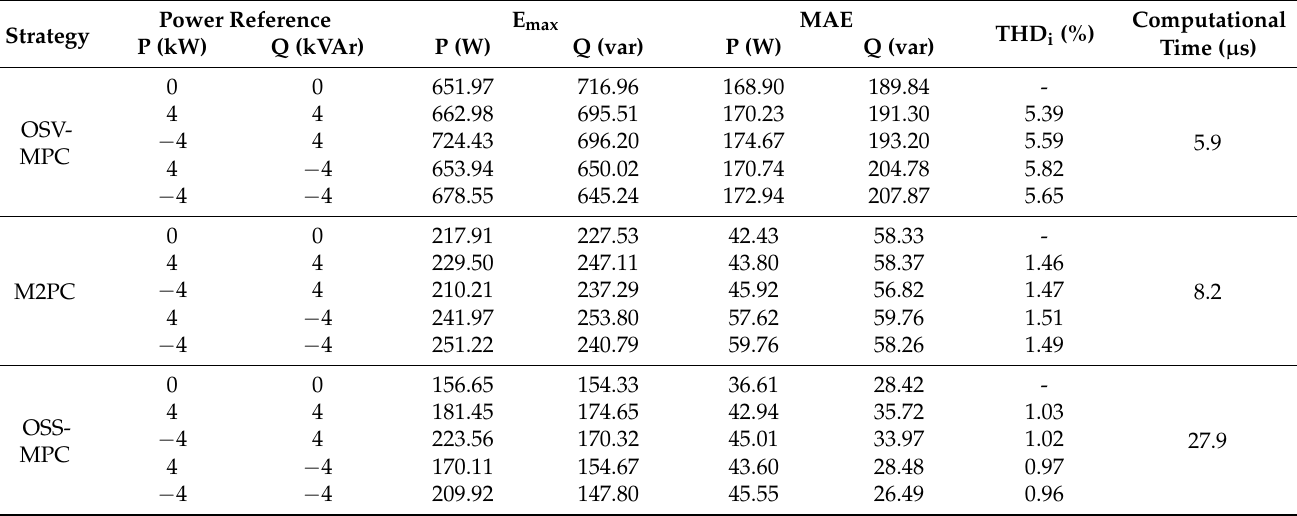
Table 4. Steady state experimental results.